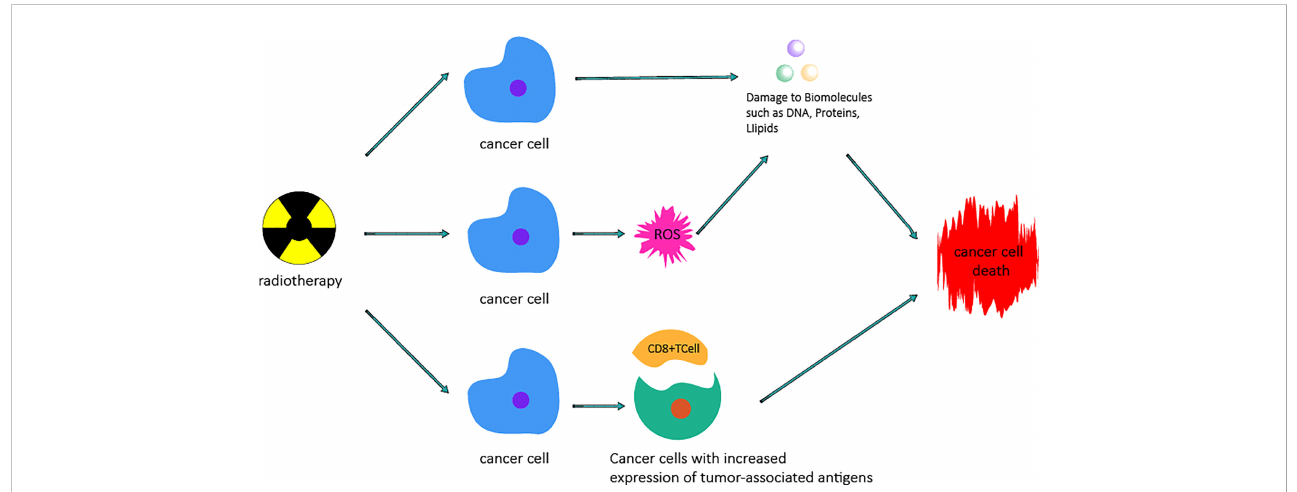
FIGURE 3 Mechanism by which radiotherapy kills cancer cells. Radiotherapy can cause damage to biomacromolecules such as DNA, protein, and lipids by direct actions or the generation of ROS by indirect actions, which can cause damage to biomacromolecules and then lead to cancer cell death. Radiotherapy increases the expression of tumor-associated antigens by altering the tumor microenvironment and stimulating the proliferation and priming of cytotoxic CD8+ T cells, thus causing cancer cell